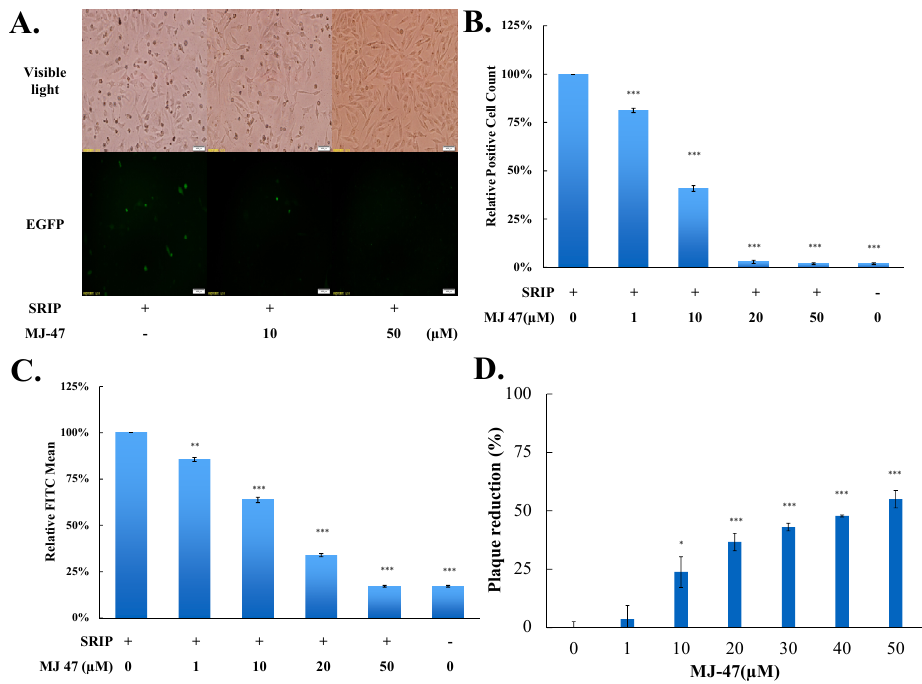
Figure 7. Measurement of IC50 value of MJ-47 against JEV using the system of JEVSRIP-infected packaging cells plus flow cytometry and the plaque reduction assay. Virus-induced cytopathic effect in packaging cells was photographed 36 h post SRIP infection in the presence or absence of MJ-47 by phase-contrast and fluorescent microscopies ( A ). In the system of JEV-EGFP SRIP plus flow cytometry, CprME-expressing packaging cells were infected with JEV-EGFP SRIPs at 10 TCID 50 in presence and absence of MJ-47, harvested 36 h post infection, and analyzed using flow cytometry. The ratio of EGFP-positive cells ( B ) and relative green fluorescent intensity ( C ) in MJ-47-treated SRIP-infected cells to those in SRIP-infected cells were represented after normalizing the un-infected cells. In the plaque assay ( D ), cell monolayer was infected with JEV (100 pfu), immediately treated with MJ-47, overlaid with 2 mL of a methylcellulose medium for 3 days, and then stained with naphthol blue-black dye. Plaque reduction was calculated from ratio of experimental data to un-treated control. *, p -value < 0.05; **, p -value < 0.01; ***, p -value < 0.001 compared with mock